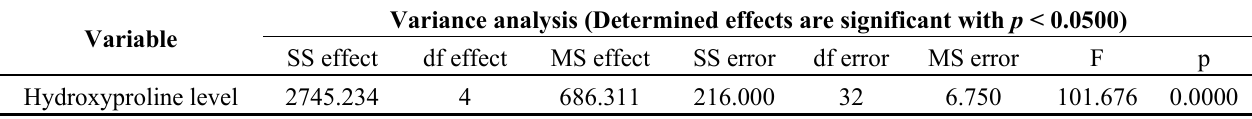
Table 2. One-way analysis of variance for independent samples.